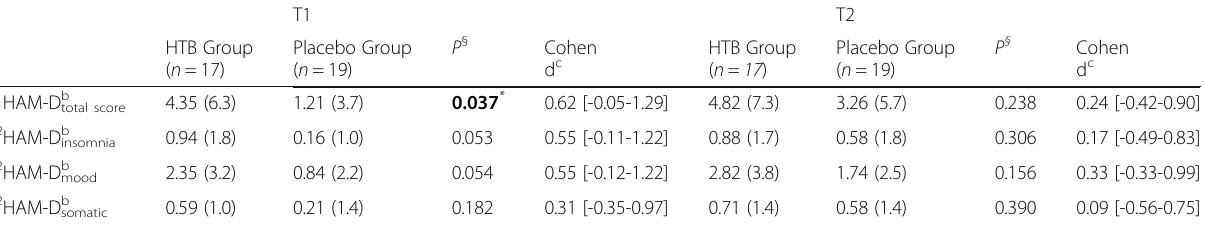
Table 3 17-Item Hamilton Scale for Depression: Differences between baseline and T1 (after 4 interventions) and T2 (4 weeks after treatment) in the hyperthermic bath group compared to the placebo group (intention-to-treat population; a N = 36)